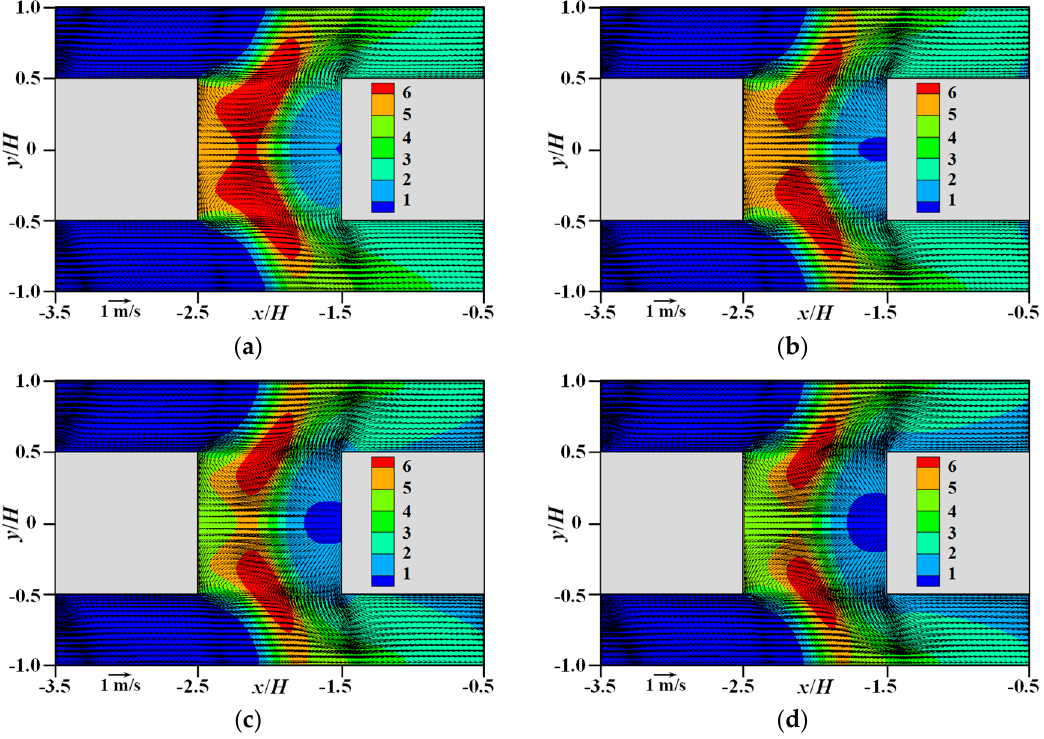
Figure 10. Mean velocity vectors and normalized concentration C / C * in horizontal plane of the PSC ( z / H = 0.1): ( a ) GH-30; ( b ) GH-40; ( c ) GH-50; ( d ) GH-60.